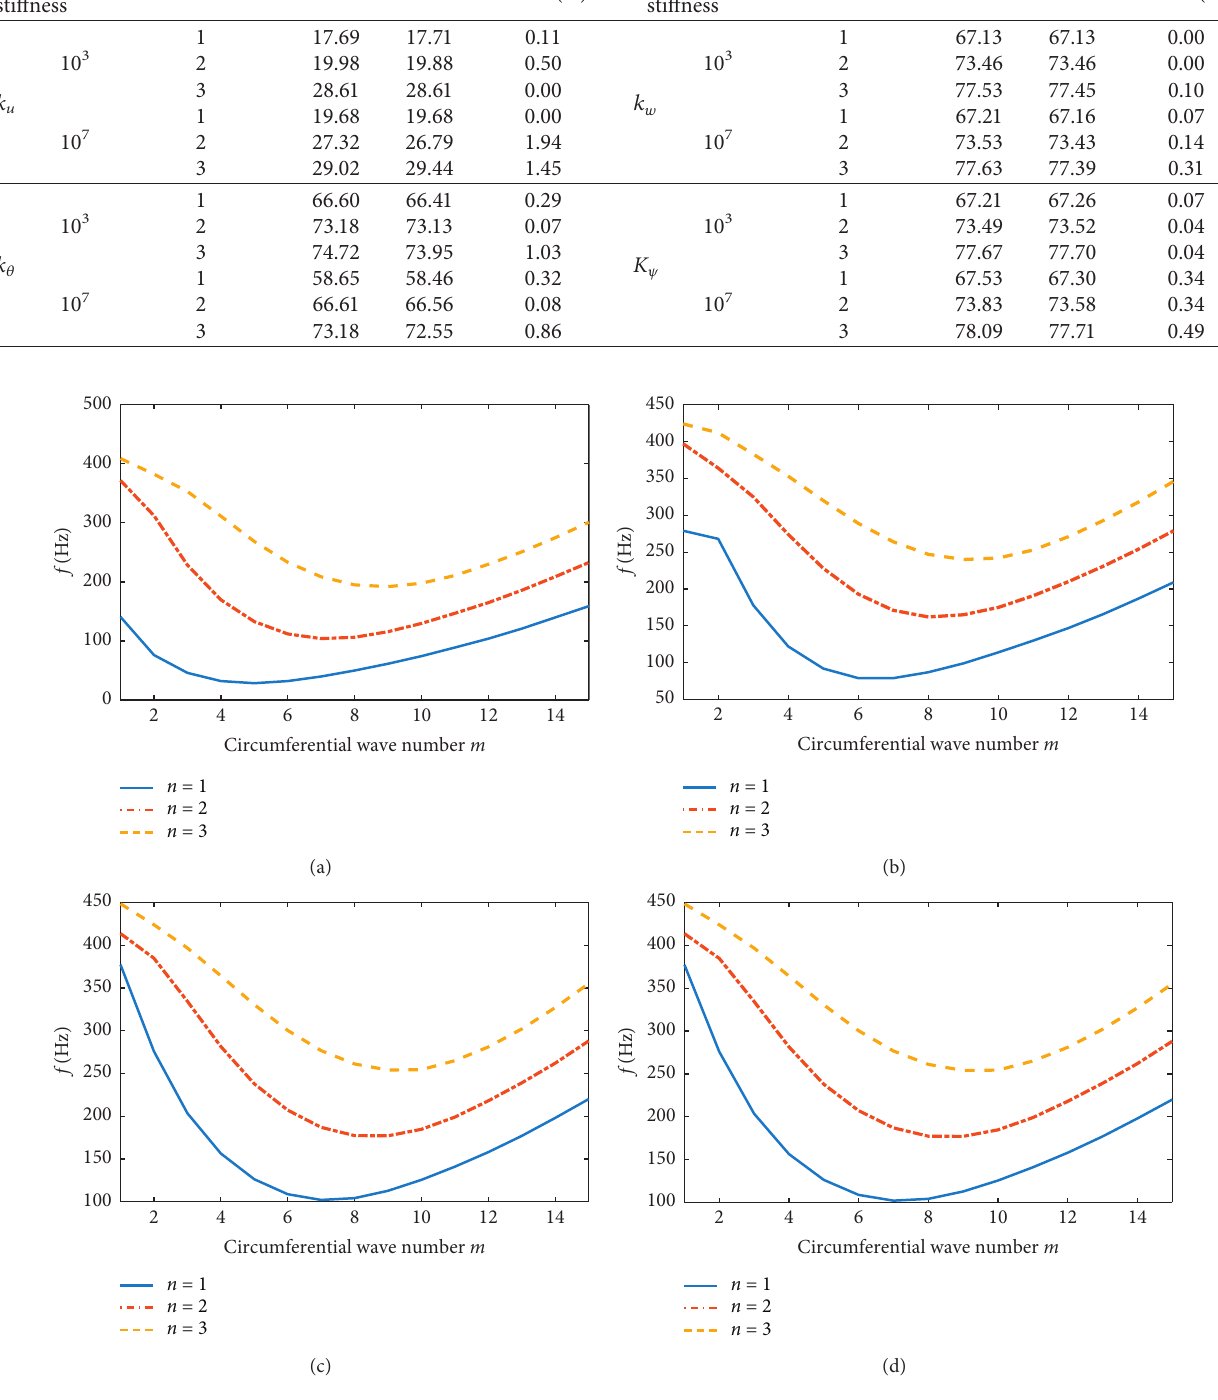
Figure 7: Frequency of conical under different boundary conditions, m � 1–3, n � 1–15. (a) C–F. (b) S–S. (c) S–C. (d) C–C.